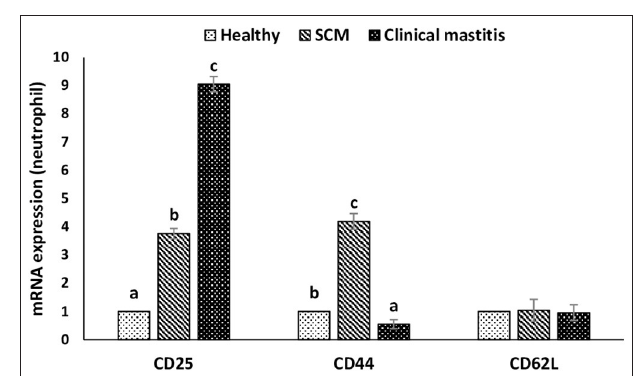
FIGURE 7 | Relative mRNA expression of various cluster of designation receptors (CD25, CD44, CD62L) on milk neutrophils of healthy, subclinical mastitis (SCM), and clinical mastitis Sahiwal cows. Data were expressed as mean ± SEM. Means statistically ( p < 0.05) different between the groups are shown with small superscript letters